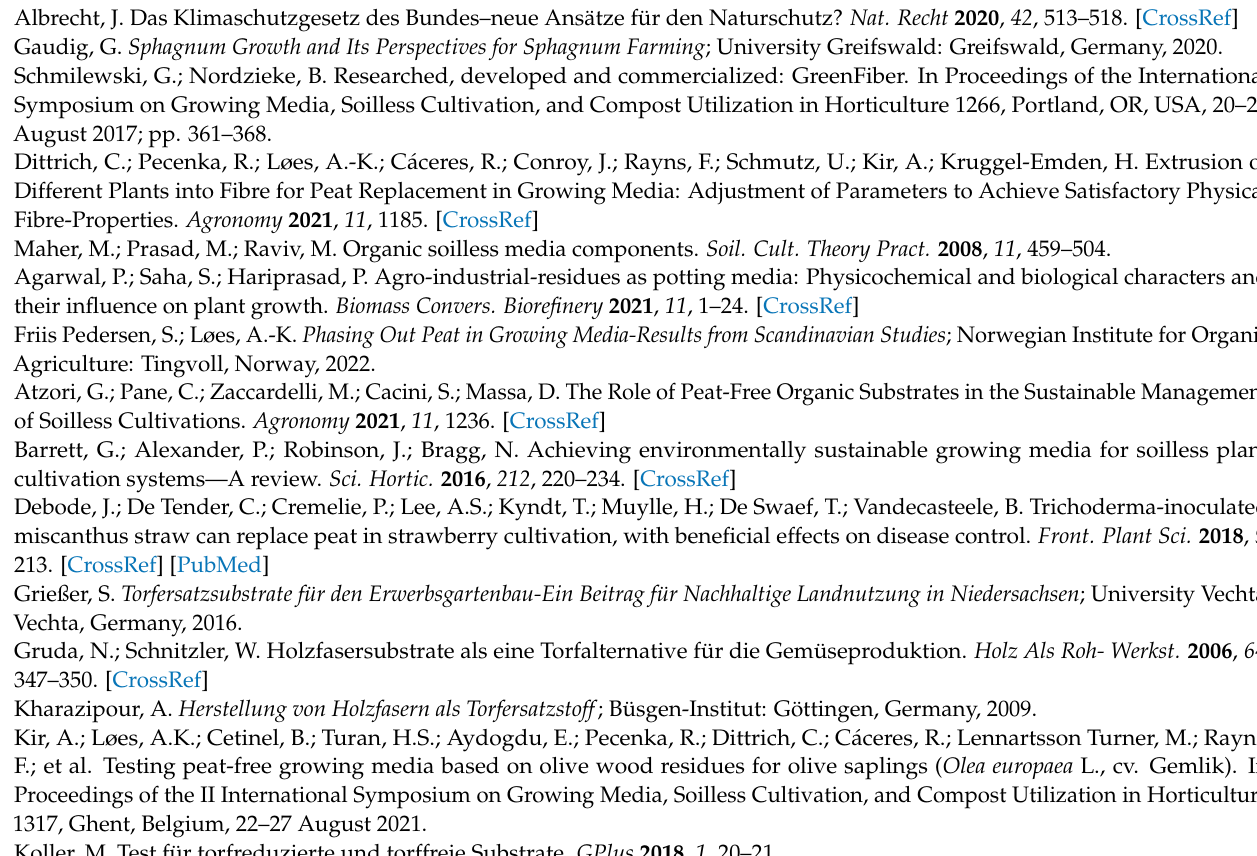
Figure A4. Correlation between WHC − 5 kPa (volume based) and X-50